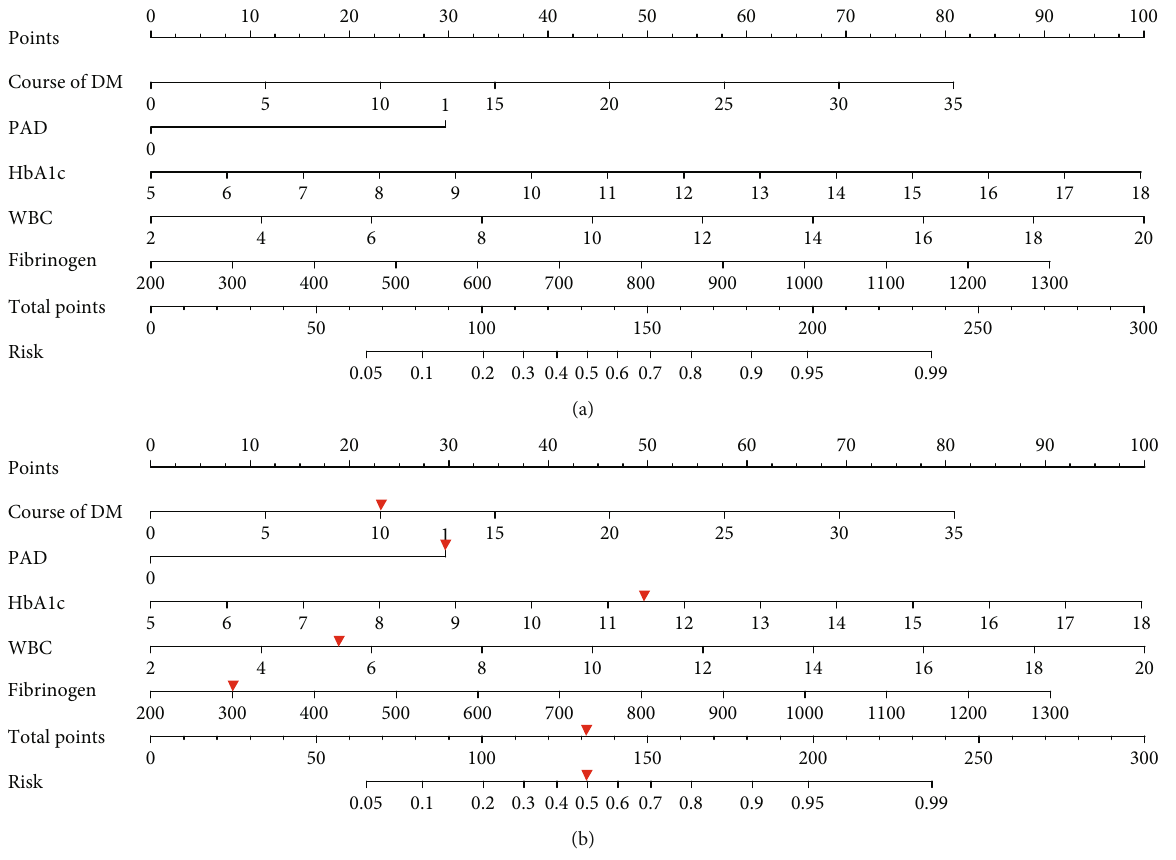
Figure 2: Development of the risk nomogram (a) and the dynamic nomogram for an example (b). The nomogram to predict the risk of amputation in patients with diabetic foot ulcer was developed with the predictors including course of diabetes, PAD, HbA1C, WBC, and